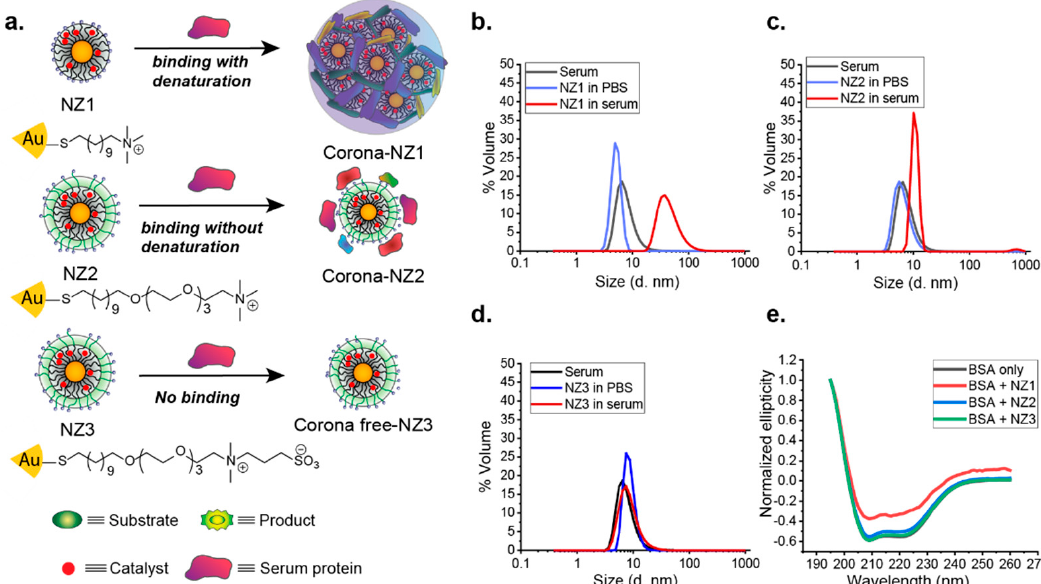
Figure 3. ( a ) Schematic illustration of tuning ligand monolayers to modulate interactions between AuNPs and proteins. As confirmed by dynamic light scattering (DLS) ( b – d ), nanozyme-2 (NZ2) formed a corona-like structure with serum proteins while NZ1 formed aggregates. Zwitterionic NZ3 showed nonfouling property in the presence of serum medium. ( e ) Circular dichroism (CD) results demonstrated that NZ1 partially denatured bovine serum albumin (BSA), inducing its conformational changes. However, NZ2 and NZ3 retained the original protein conformation. (Adapted with permission from Reference [68]; Published by American Chemical Society, 2020).